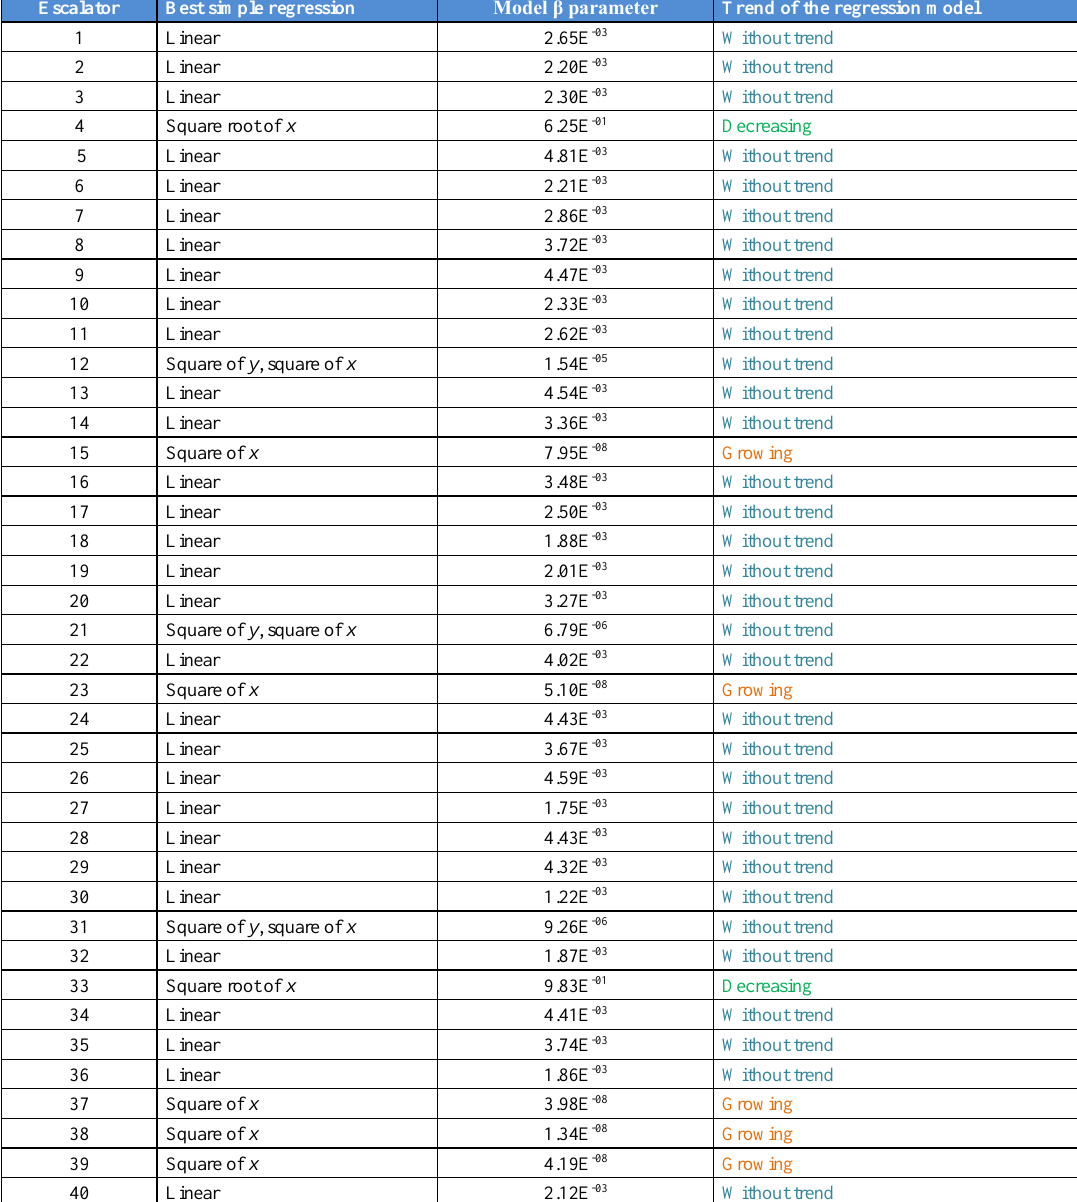
Table 2. Estimated simple regression models of E[N(t)] on escalators model TNE.